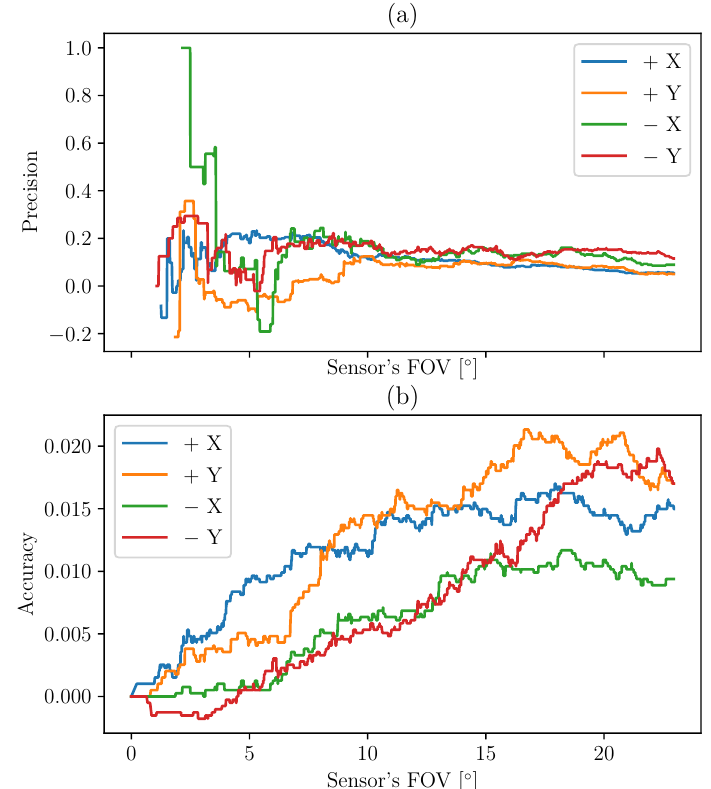
Figure 13. Difference between the precision ( a ) and accuracy ( b ) of the MEKF and the TRIAD methods based on the UVS indicator (positive means that MEKF has better performance compared to